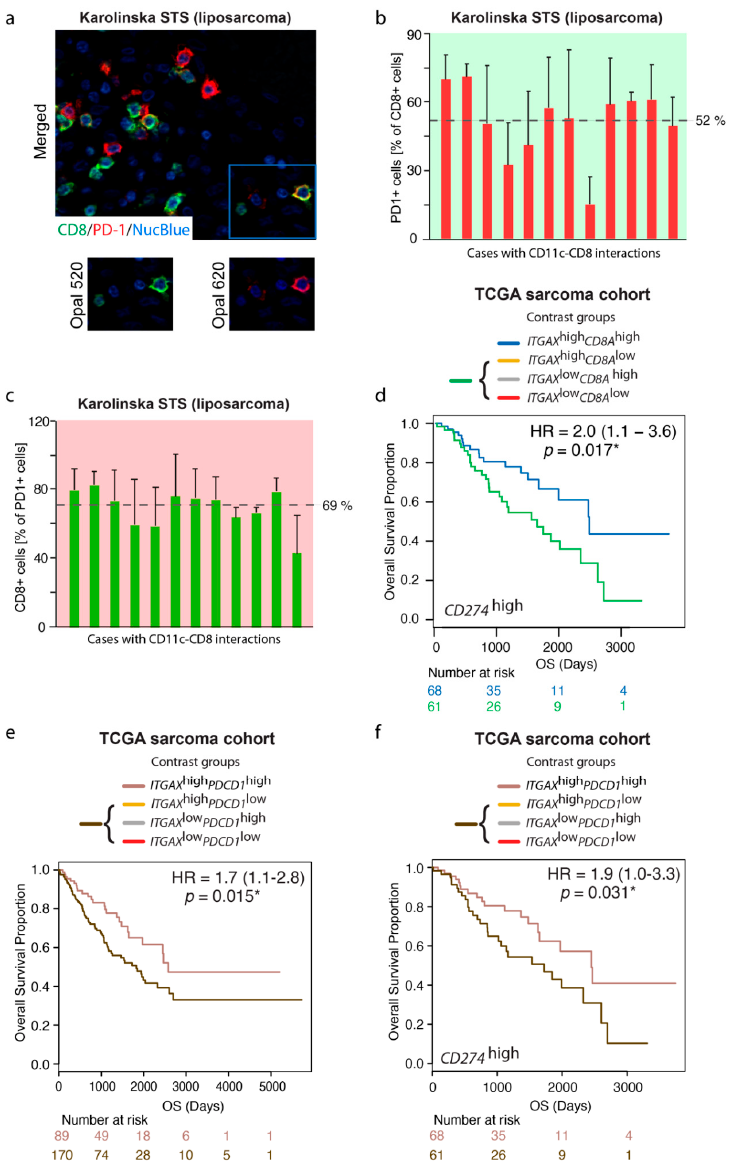
Figure 5. The prognostic value of the ITGAX high CD8A high gene signature is maintained in a CD274 (PD-L1)-rich TME. ( a ) Double IF (Opal™ multiplexing) visualizing three types of immunopositive cells: CD8+/PD1+, CD8+/PD1-, and CD8-/PD1+ in liposarcoma. Blue pseudocolor=nuclei; ( b ) QuPath image quantification of PD1+ cells among the CD8+ T cell population (+SD from 3 different 3 x 3 tiled/stitched images). The average percentage of positive cells is indi- cated with a dotted line. Each bar represents an individual case displaying CD11-CD8 interactions; ( c ) QuPath digital image quantification of CD8+ cells among the PD1+ cell population (+SD from 3 different 3 × 3 tiled/stitched images). The average percentage of positive cells is indicated with a dotted line. Each bar represents an individual case display- ing CD11-CD8 interactions; ( d ) Contrast group analysis of gene expression levels of ITGAX (CD11c) and CD8A in